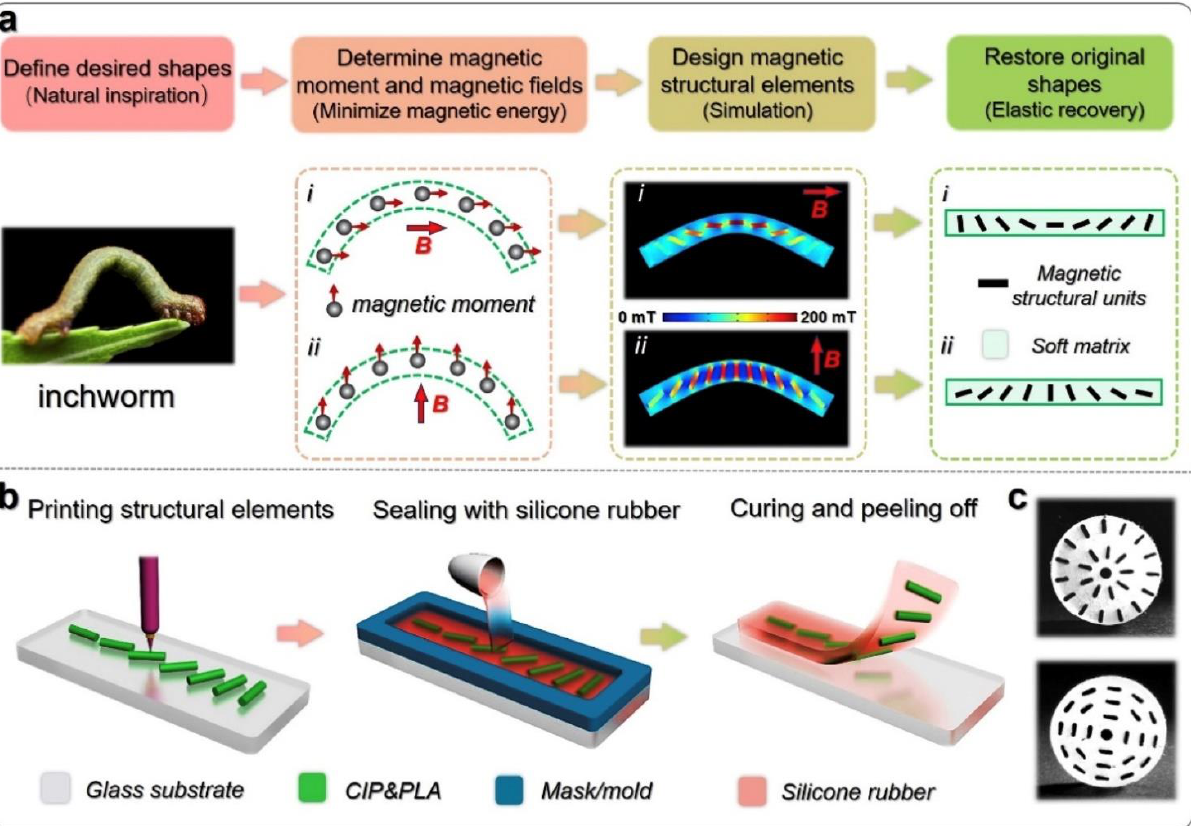
Figure 10. ( a ) Shape-programming strategy for imitation of an inchworm. The deformations are simulated by COMSOL, and the direction of the magnetic field is indicated by the red arrows. ( b ) Three-dimensional printing of magnetic elements and encapsulation by silicone rubber. ( c ) Photos of samples with oriented magnetic structural elements. The radius of the disk samples is 10 mm. Reprinted from [76], copyright (2020), with permission from Elsevier.